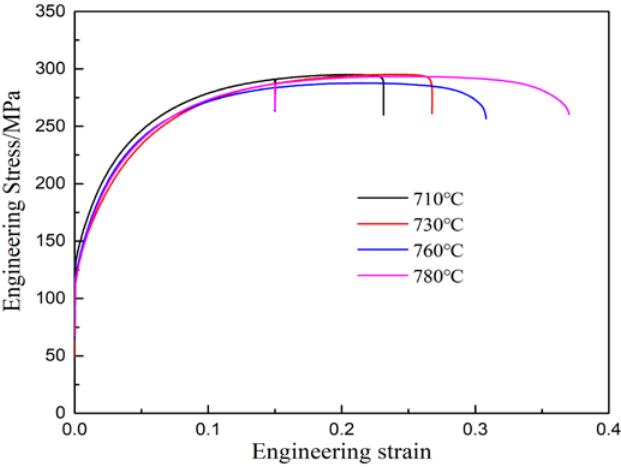
Figure 3. Engineering stress–strain curves at different annealing temperatures perpendicular to the rolling direction.